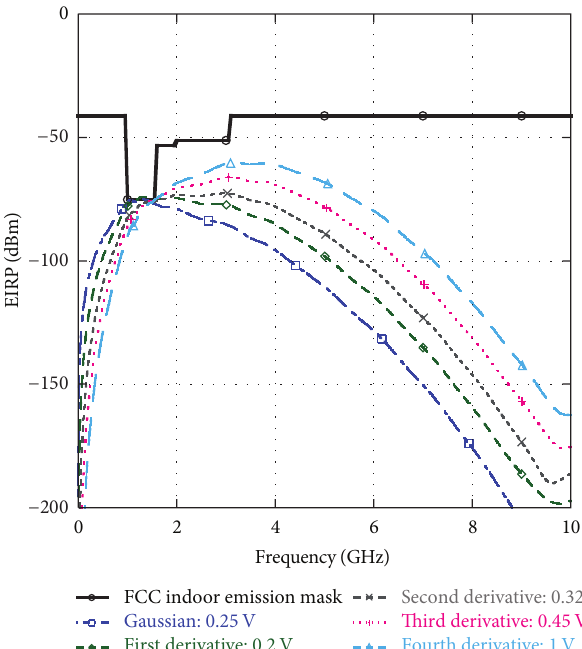
Figure 1: Computed EIRP for various pulse shapes achieved with a real UWB antenna. The maximum pulse amplitude that gives rise to EIRP in compliance with FCC indoor emission mask is reported.